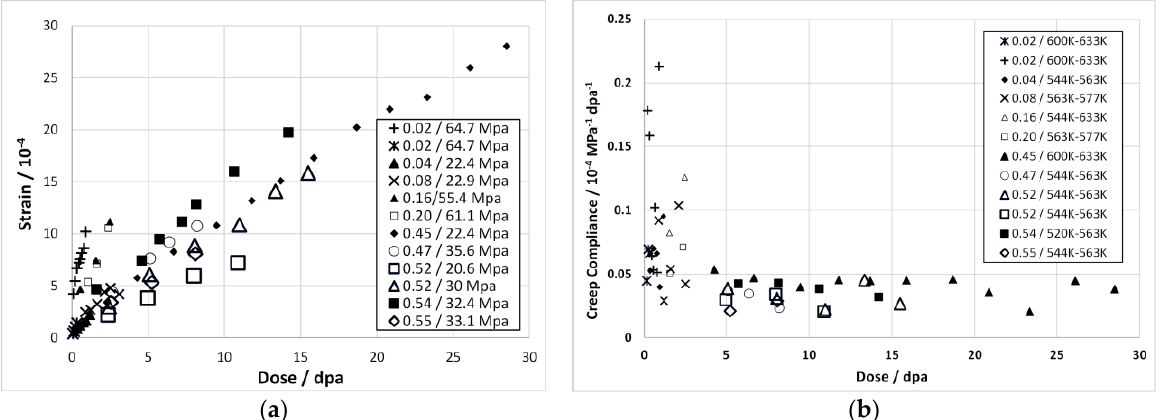
Figure 29. Creep strain and compliance as a function of dose rate for 316 SS springs irradiated in Dounreay fast reactors at temperatures between 520 and 633 K (247–360 °C): ( a ) strain as a function of dpa dose; ( b ) compliance as a function of dpa dose. The legend shows the dpa rate (in units of 10 −7 dpa s −1 ) and stress for each dataset. Modified from [68].